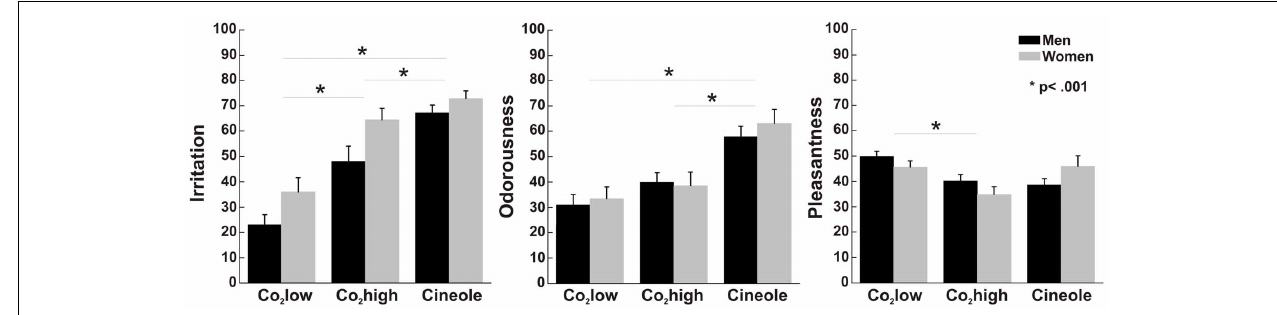
FIGURE 5 | Perceptual ratings with error bars representing standard error of the mean. Women rated all stimuli as more irritating than men but no sex differences were found for either pleasantness and or odorousness. In